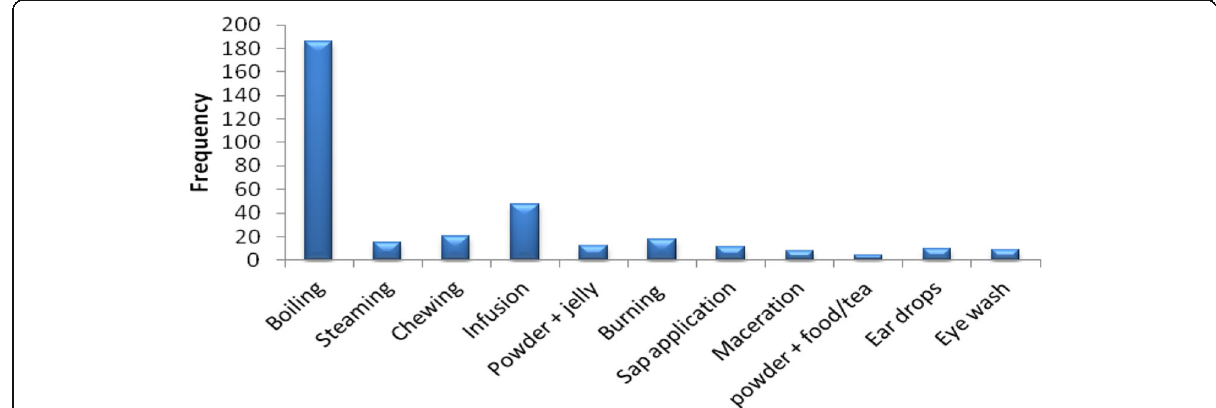
Fig. 6 Methods of preparing herbal